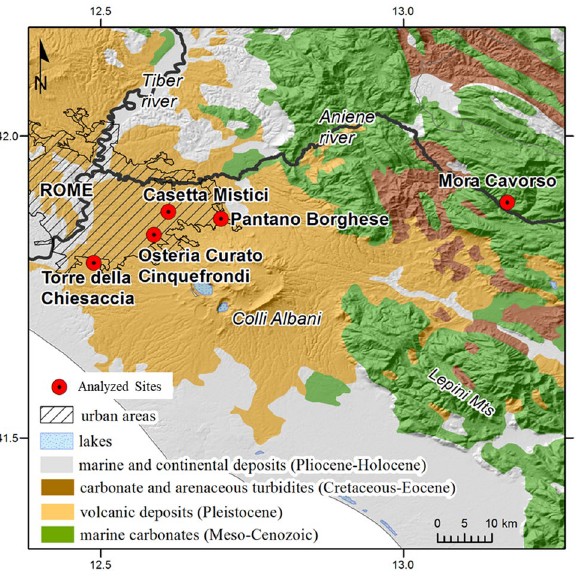
Figure 4. Location of the Roman sites. The geological features are shown in colors. Line-shading covers the current urban area of Rome. Geological units are from SGI-ISPRA geoportal (available at http://sgi.ispra mbien te.it/geopo rtal/catal og/main/home.page); hillshade was created using a GTOPO30 (Global 30 arc-second elevation) Digital Elevation Model, from the USGS database (accessible at ) with a resolution of 30 ″ × 30 ″ (about